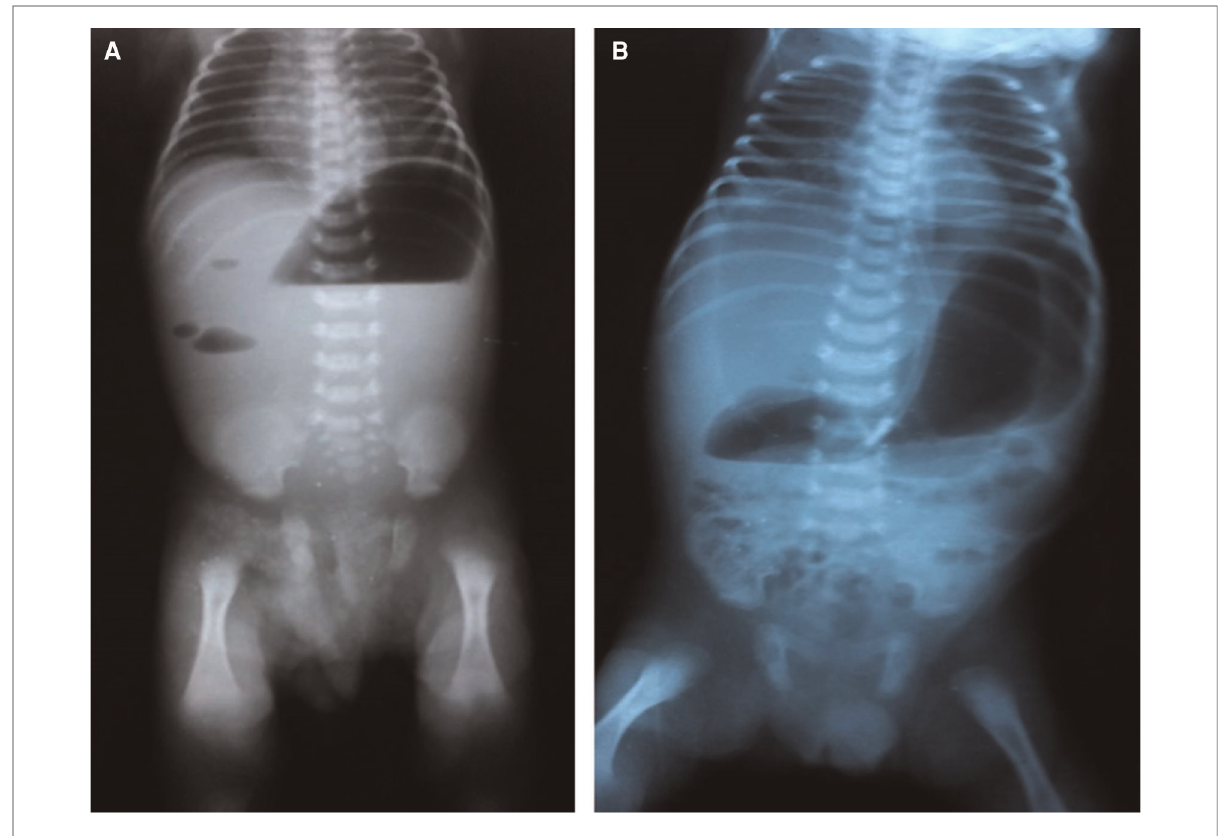
FIGURE 2 Erect x-ray of the abdomen. ( A ) At admission. ( B ) Three days